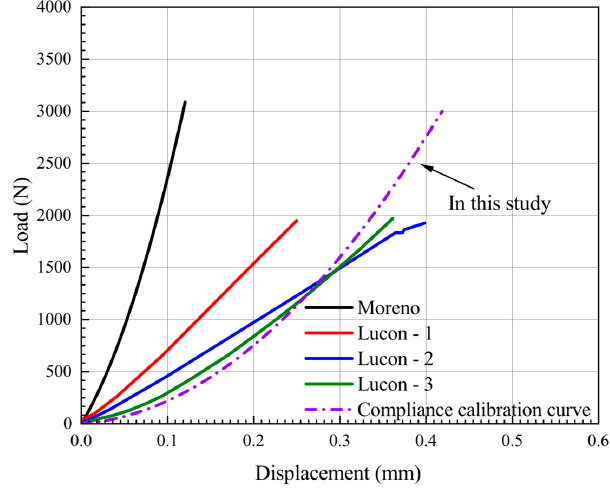
Figure 10. Compliance calibration curve by different